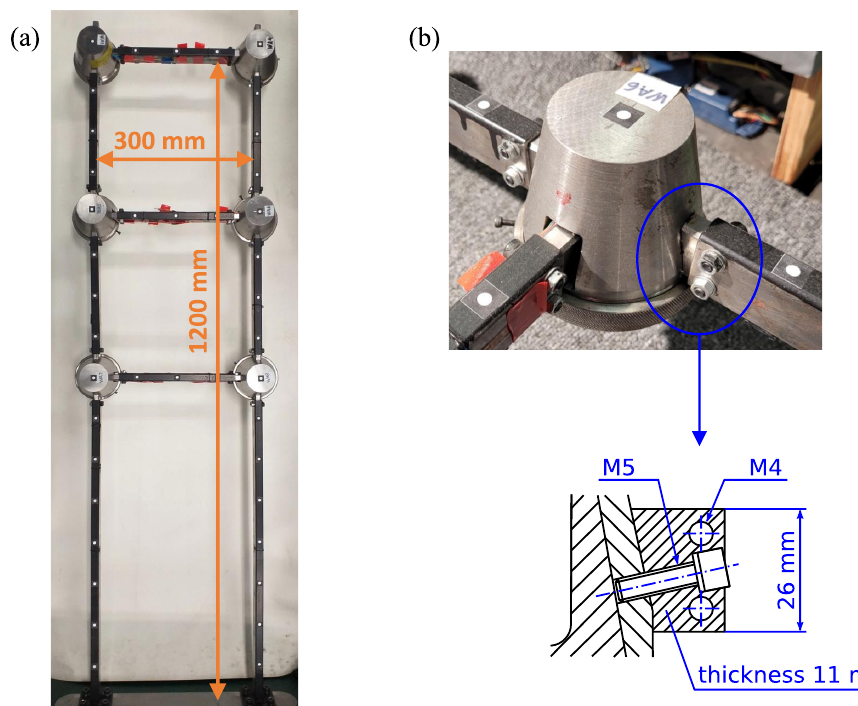
Figure 2. Photo of ( a ) investigated frame structure and ( b ) details of the bolted